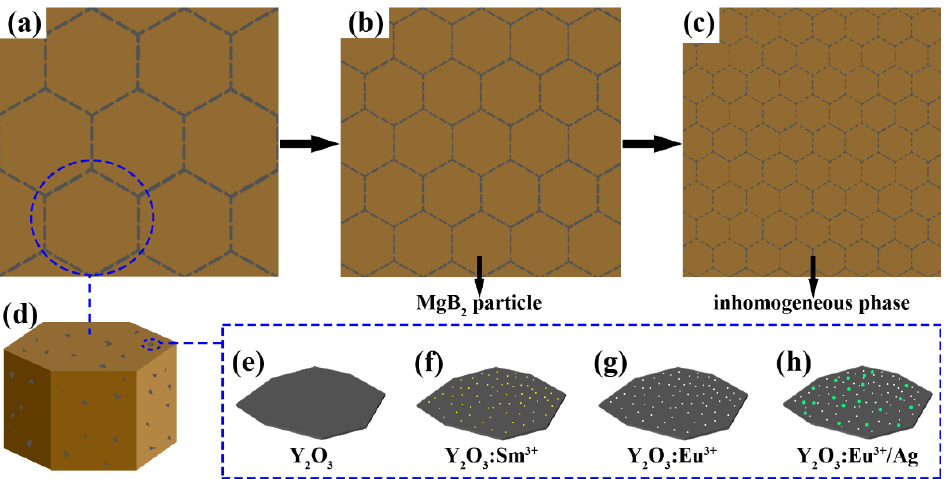
Figure 1. The models of MgB 2 SMSCs prepared using ( a ) a MgB 2 ( Φ a < 30 μ m), ( b ) b MgB 2 ( Φ b < 15 μ m), and ( c ) c MgB 2 ( Φ c < 5 μ m) as raw materials. Schematic depictions of ( d ) a particle of MgB